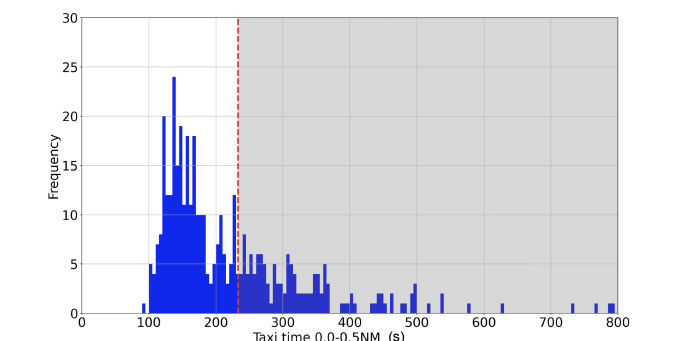
Figure 15. Determining departures waiting in the queue based on taxi time within 0.5 NM from the runway 05 entry